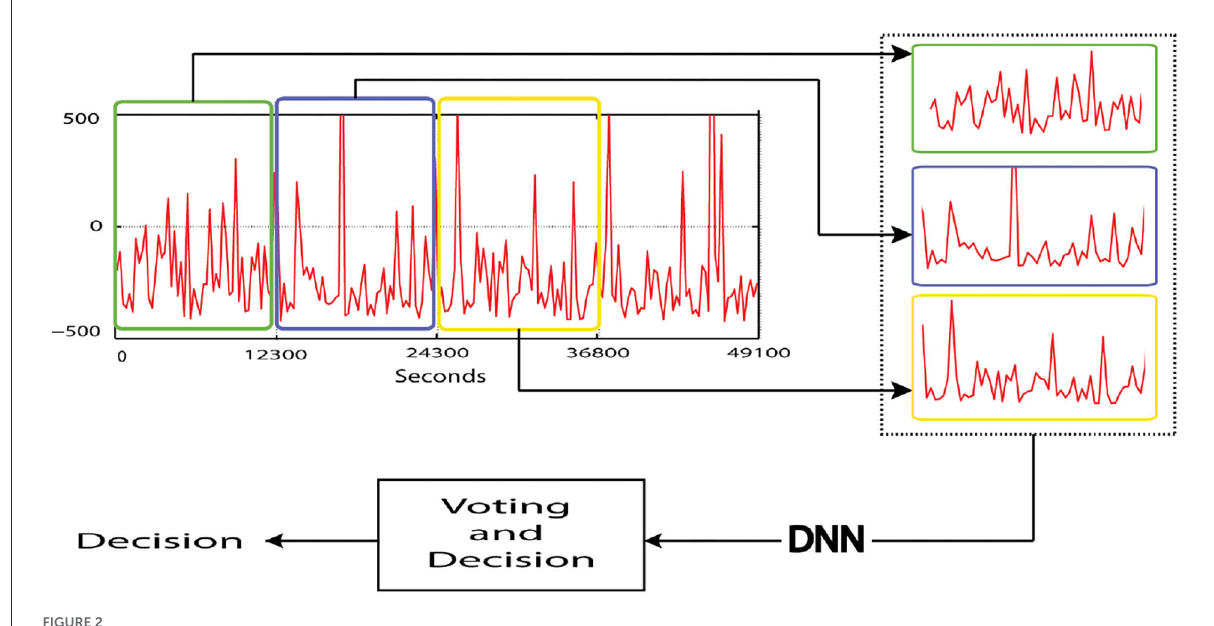
FIGURE2 Division of the signal architecture.